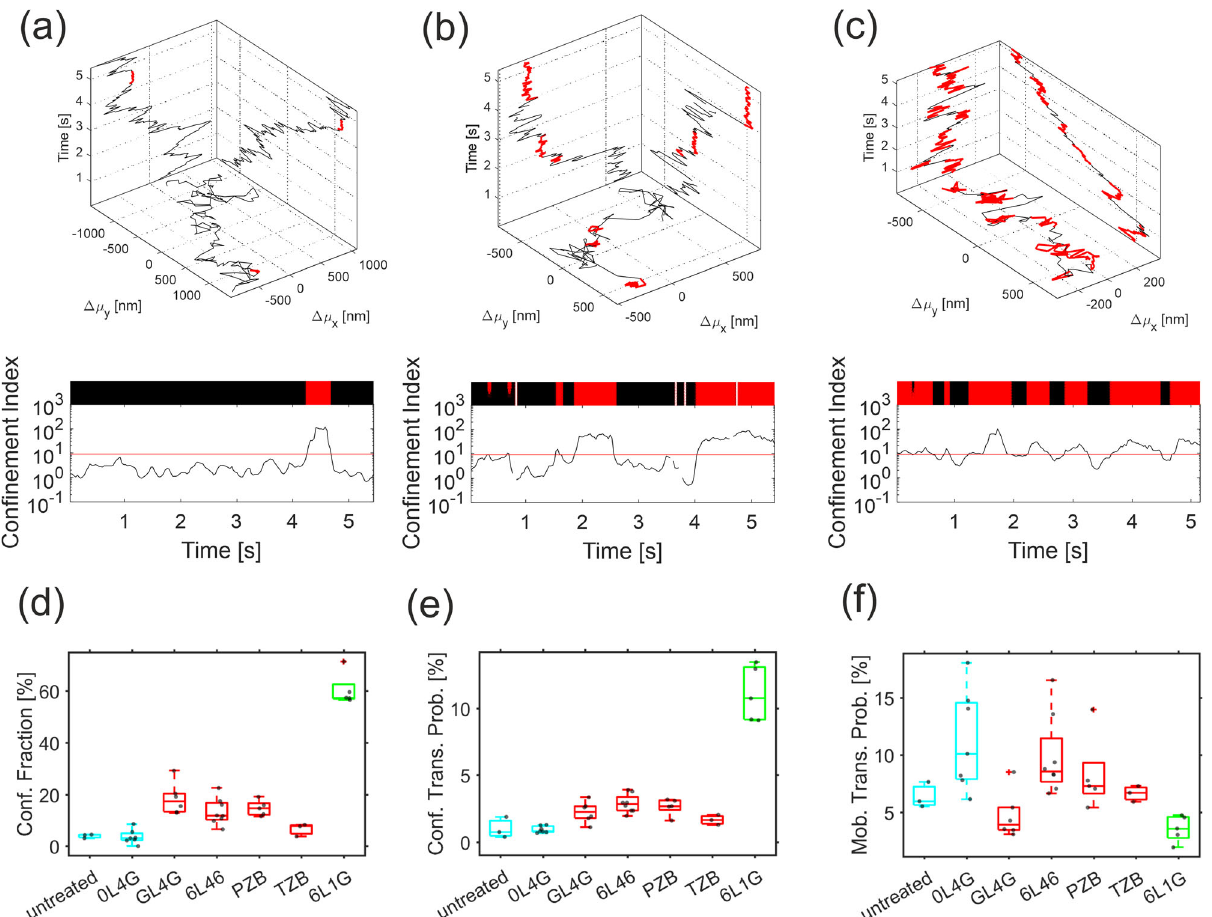
Fig. 7 Lockdown is related to transient arrest of HER2. a , b , c Transient arrest events (highlighted in red) within individual HER2 trajectories (top) determined from the con fi nement index calculated along a representative trajectory (bottom) upon treatment with OL4G ( a ), GL4G ( b ), and 6L1G ( c ). The threshold de fi ning transient arrest events is indicated by the red line. d Identi fi ed fraction of con fi ned particles. e Probability of transitioning into state of arrested diffusion. f Probability of mobilization out of arrested diffusion. Different colors in d – f indicate the three distinct groups of agents as described in Fig. 6 and referenced in the main text. The DARPins are shown schematically in Supplementary Fig. 1. Signi fi cance values for d – f are provided in Supplementary Fig.